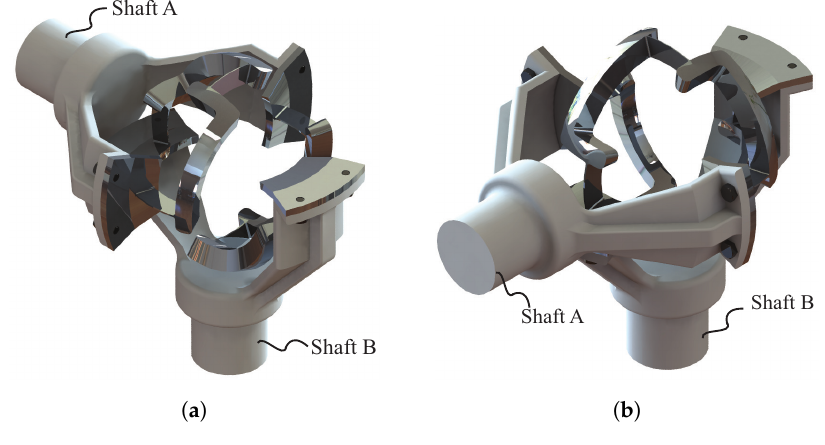
Figure 1. CAD model of a possible embodiment design of the fully-compliant spherical joint composed of two spherical serial chains: isometric views, ( a , b ), from different angles.